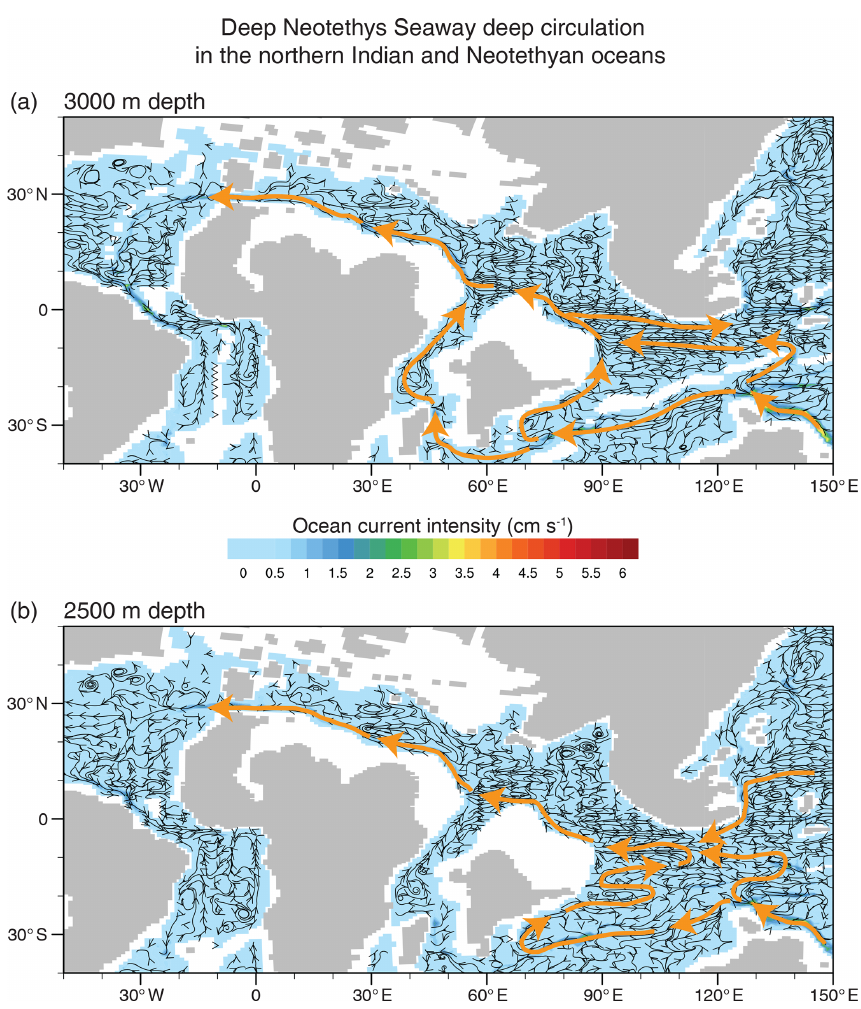
Figure 15. Deep Neotethys Seaway deep ocean circulation in the northern Indian and Neotethys oceans at (a) 3000m depth and (b) 2500m depth. Orange contours represent major pathways of water